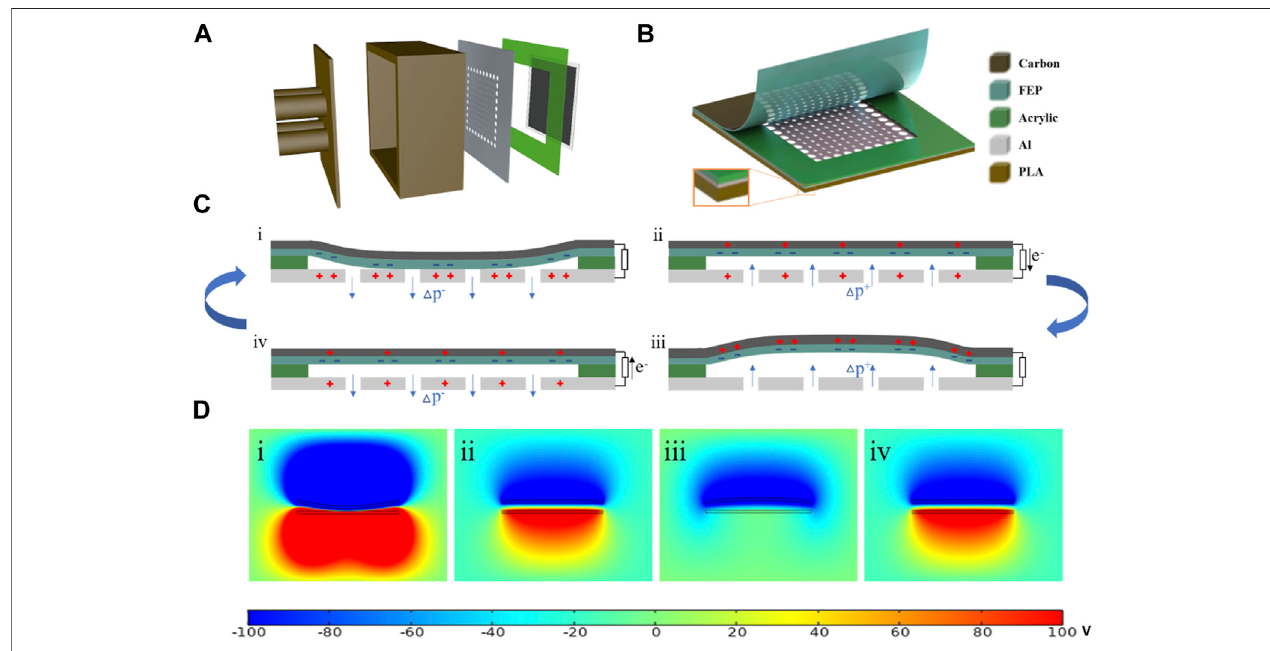
FIGURE 1 | (A) Component design of the MH-TENG (B) Component details diagram and material selection of TENG transducer device (C) Working principle diagram of the TENG transducer in one working cycle (D) Potential simulations of two friction interfaces of a TENG transducer by COMSOL.